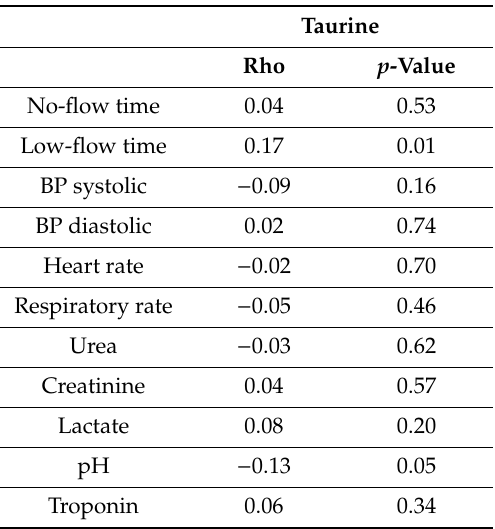
Table 2. Spearman rank correlations of taurine and clinical